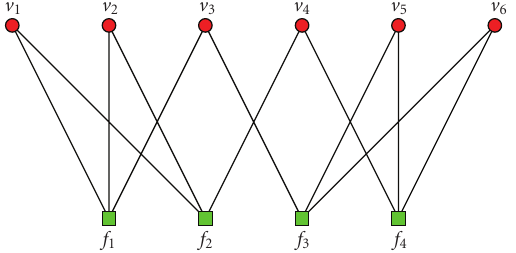
Figure 1: Tanner graph of a (2,3)-regular LDPC code.